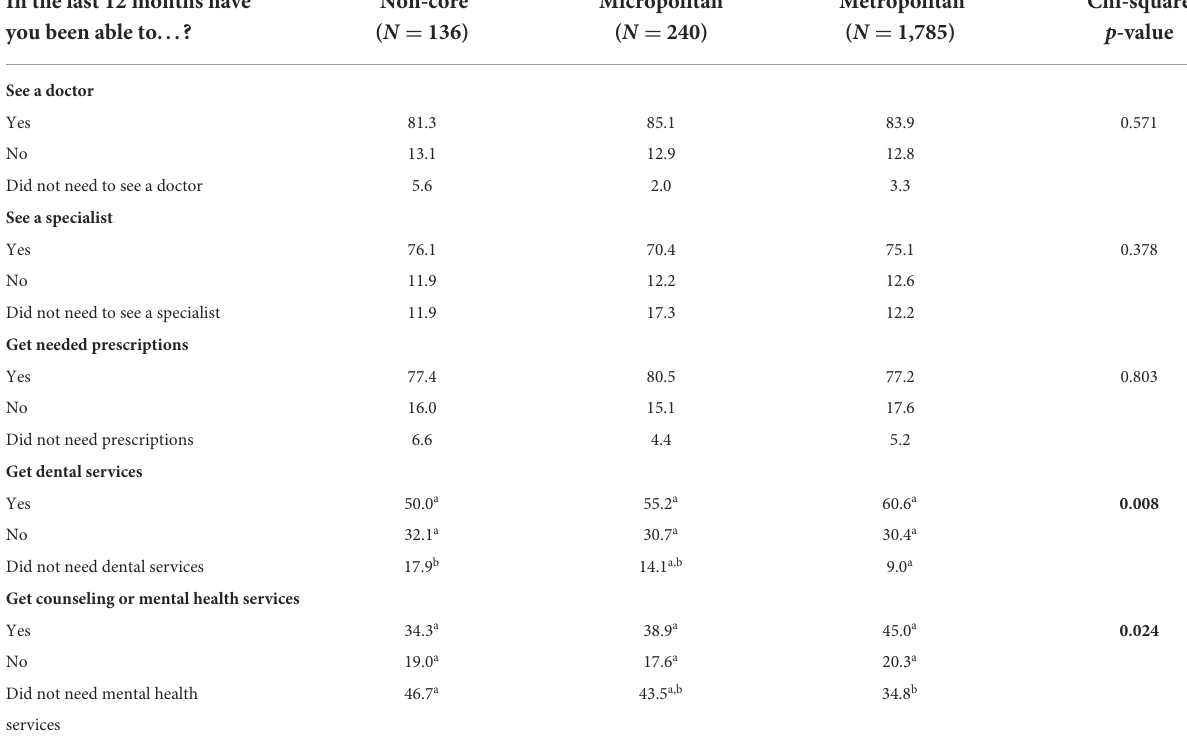
TABLE 2 Unmet and perceived service need (%), by geographic